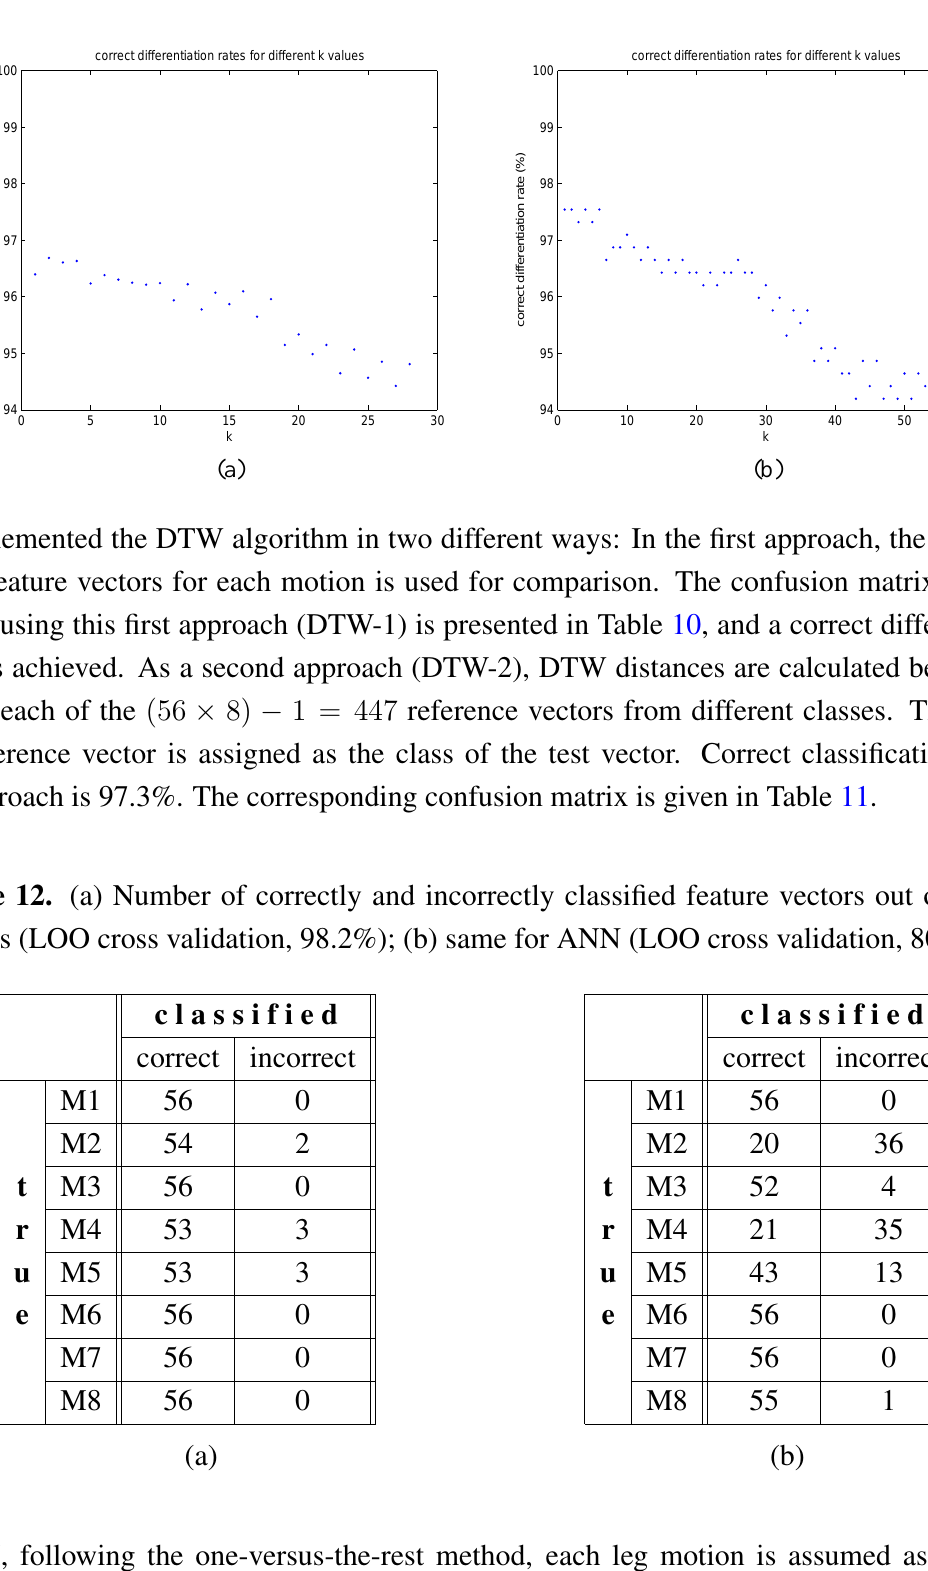
Figure 13. Correct classification rates of the k -NN algorithm for (a) k = 1 , . . . , 28 (RRSS) and (b) k = 1 , . . . , 55 (LOO).